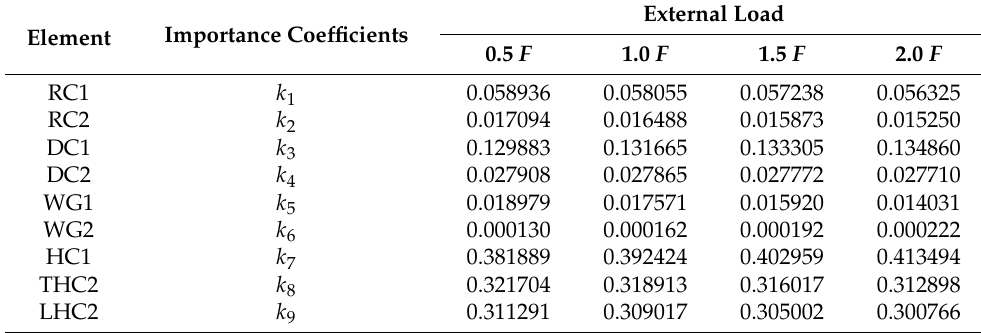
Table 3. Importance coefficients of the elements under different external